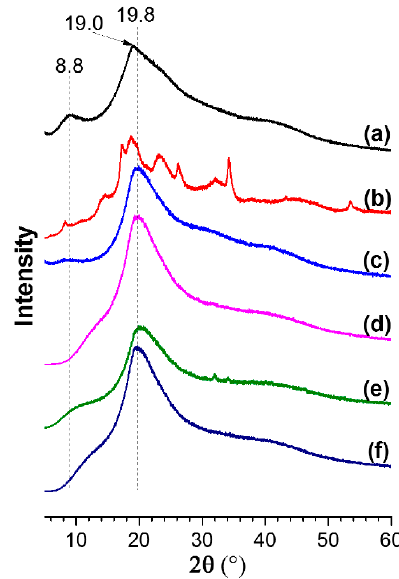
Figure 5. XRD patterns of SPI powder ( a ), SDBS ( b ), and films of SPI ( c ), SPI/SDBS ( d ), SPI/SDBS/PEGE4% ( e ), and SPI/PEGE4% ( f ). Table 3. Crystallinity of the SPI powder, SDBS and SPI-based films. Specimen